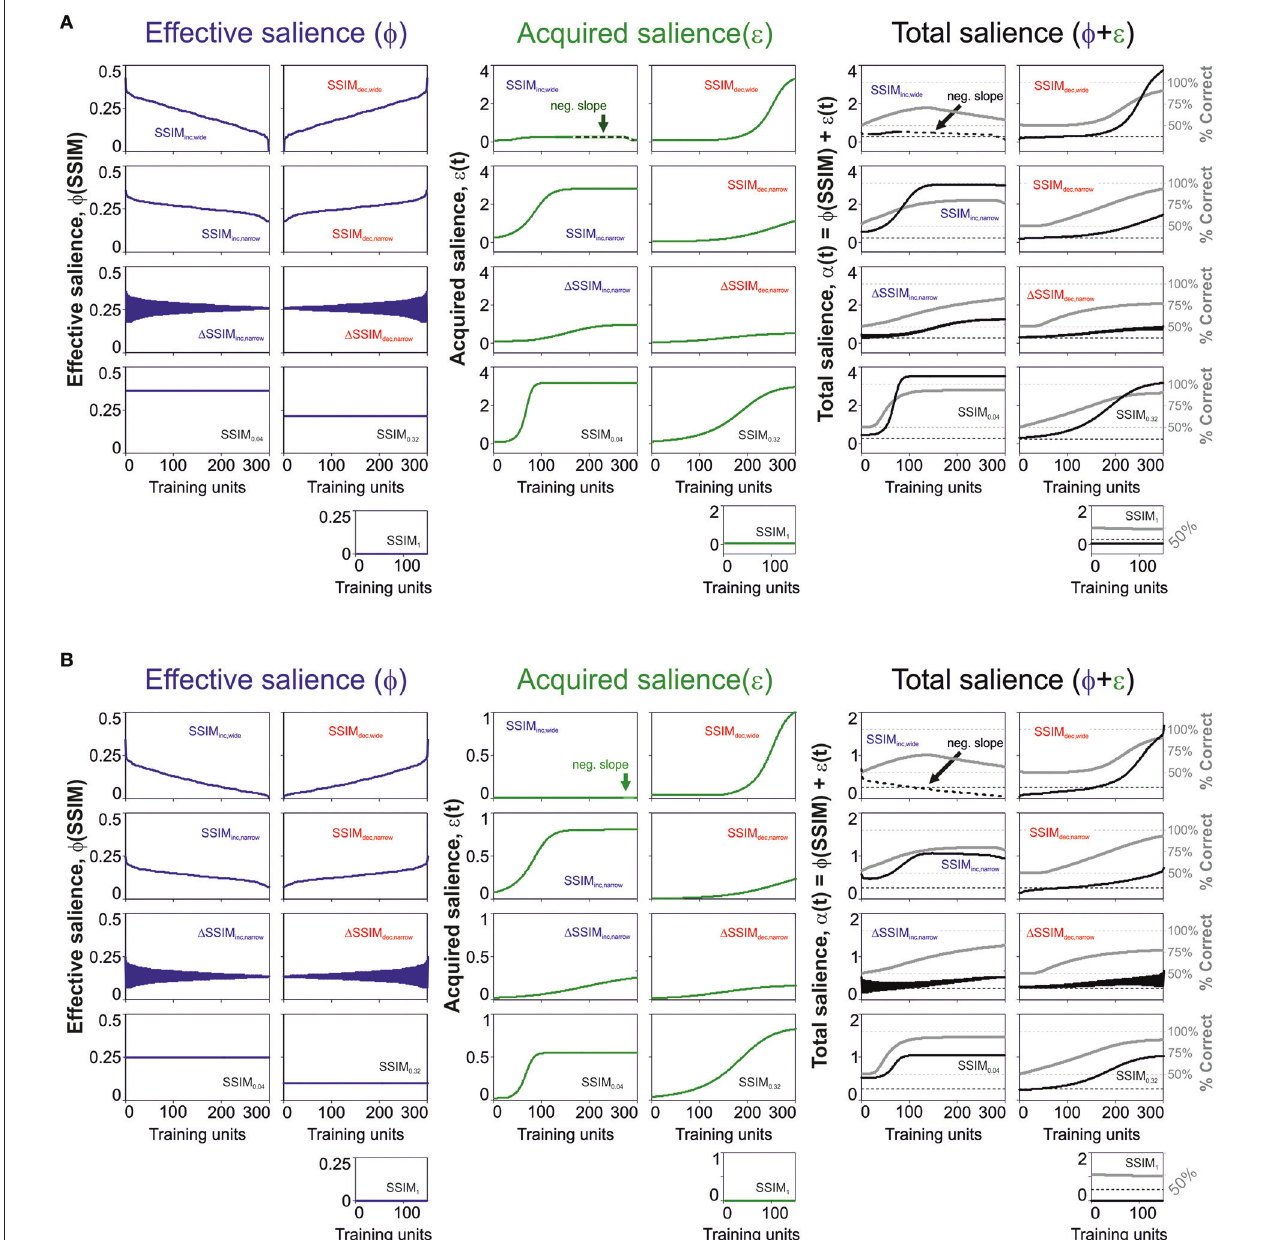
FIGURE 4 | Changes in effective and acquired salience through training. Dynamic changes in effective (blue lines), acquired (green lines), and total (black lines) salience for the best predictive model parameters using “unbound” (0 > φ ≥ ∞; 0 > ε ≥ ∞ ; A ) and “bound” (0 > φ ≥ 1 ; 0 > ε ≥ 1; B ) salience conditions. The gray lines on the right panels correspond to the predicted associative strength